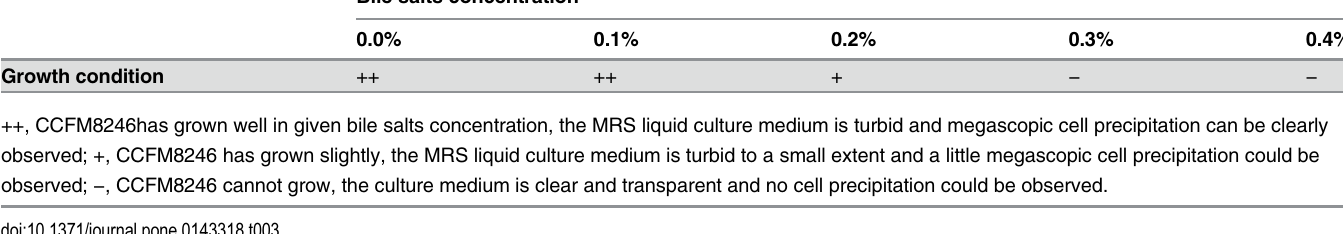
Table 3. The growth of L . plantarum CCFM8246 in bile salts of different concentration.